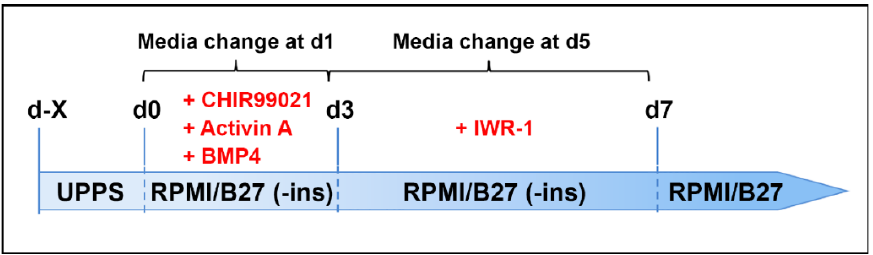
Figure 2. Scheme of the cardiac differentiation protocol (hybrid method).